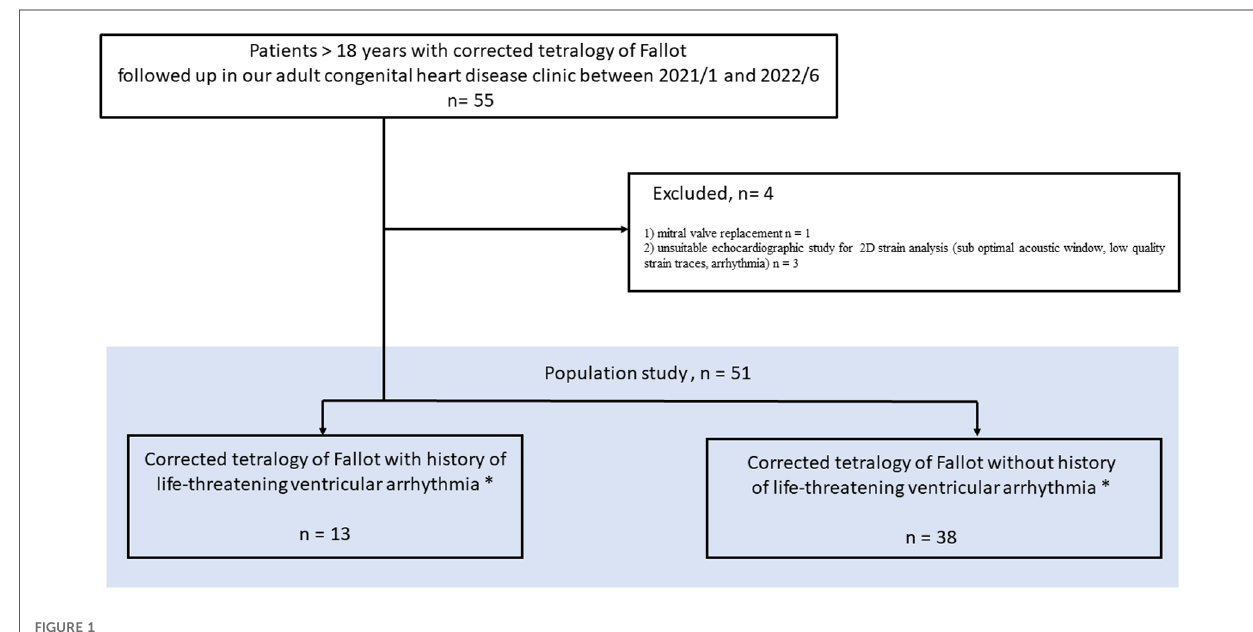
FIGURE 1 Study fl ow